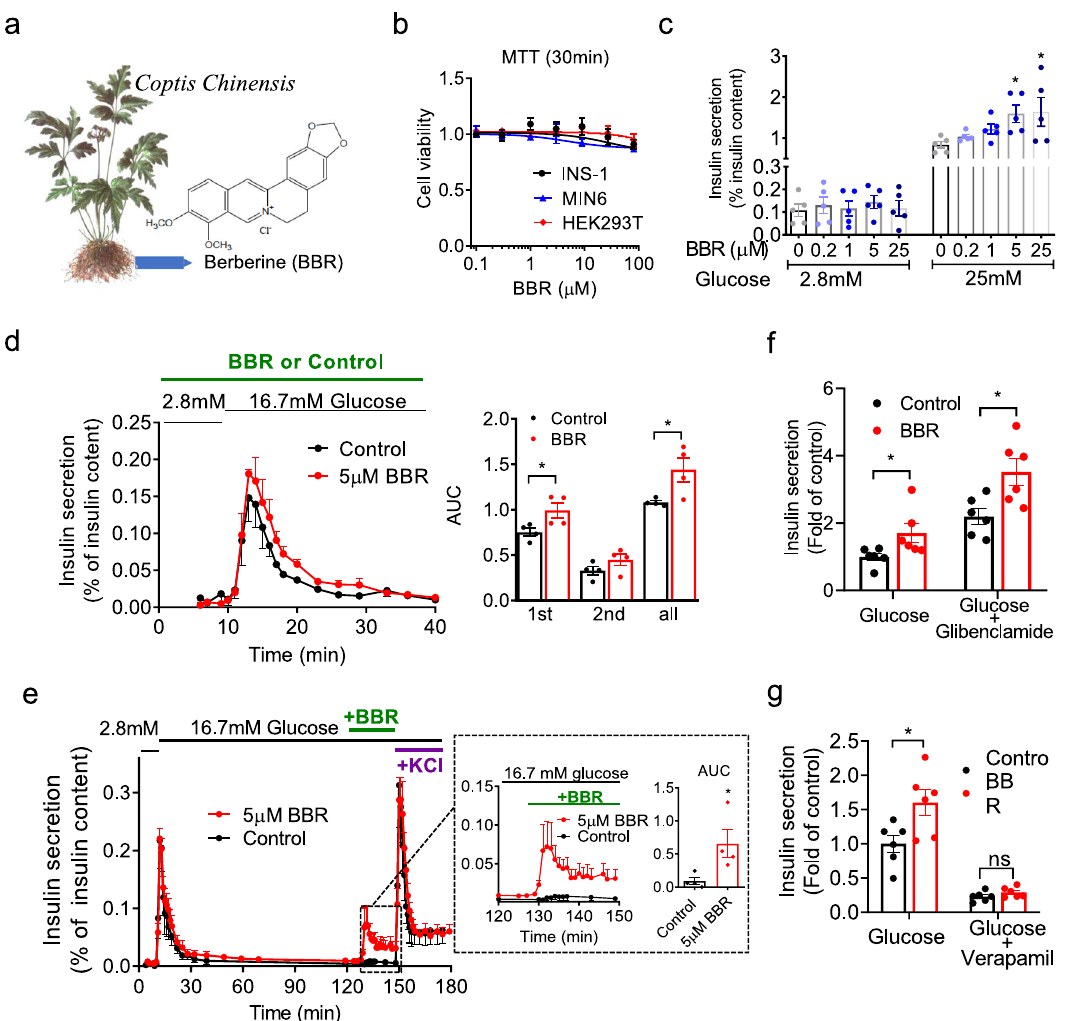
Fig. 1 BBR increases high-glucose-dependent insulin secretion from pancreatic islets. a Berberine (BBR) is a plant alkaloid isolated from the Coptidis rhizoma, the dried rhizome of Coptis chinensis . b Viability of the indicated cells incubated with different concentrations of BBR for 30 min. n = 5. c Mouse islets (15 islets per batch) were incubated with low (2.8 mM) or high (25 mM) glucose concentrations in the absence or presence of the indicated concentrations of BBR. The secreted insulin level in the supernatant was normalized to the corresponding insulin content of the islets. n = 5. P = 0.0417